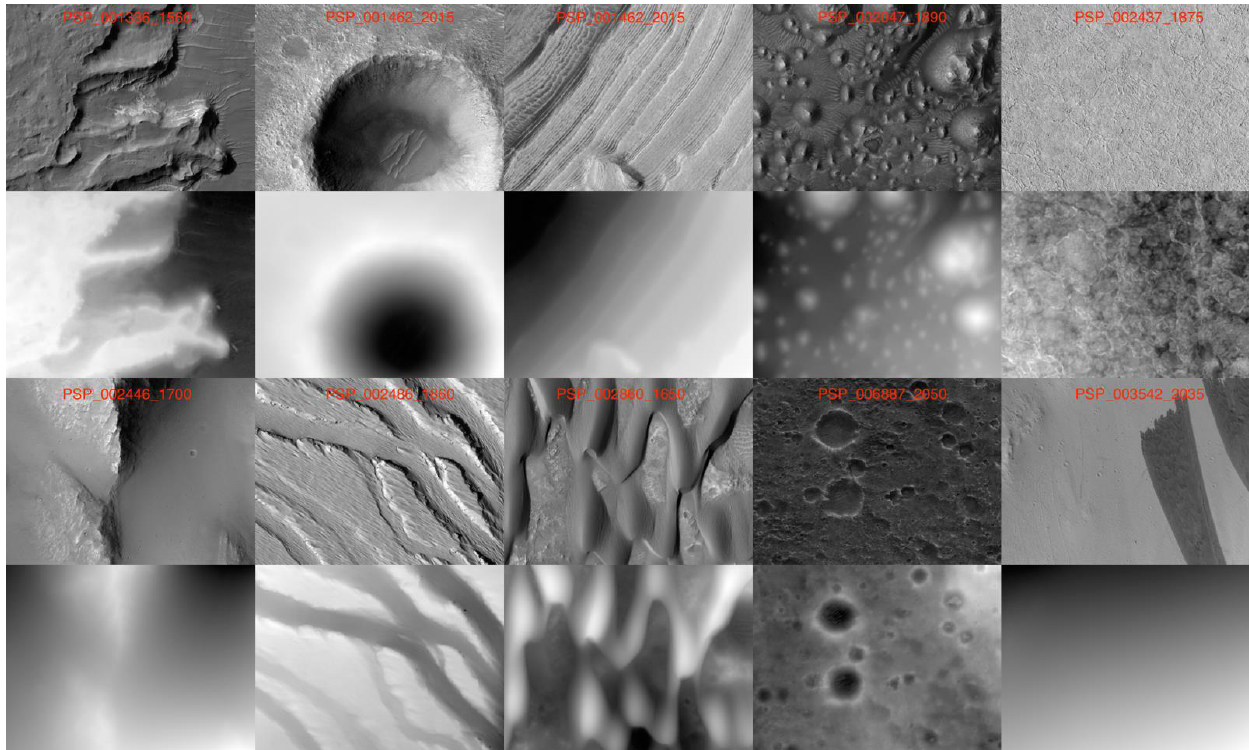
Figure 3. Examples of the training datasets: 1st and 3rd rows are the cropped HiRISE PDS ORIs (image IDs superimposed on the image in red colour); 2nd and 4th rows are the corresponding HiRISE PDS DTMs (rescaled to relative heights of [0, 1]). Size: 2560 m width, 1920 m height.